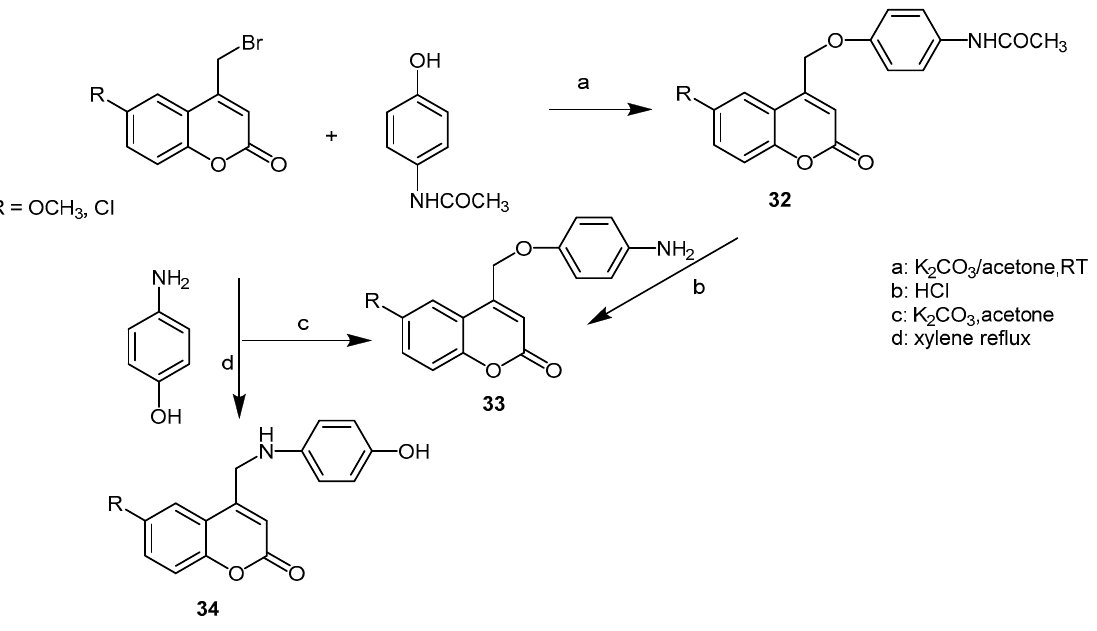
Figure 5. Synthesis of paracetamol modified Figure 4. Synthesis of paracetamol modified coumarins.